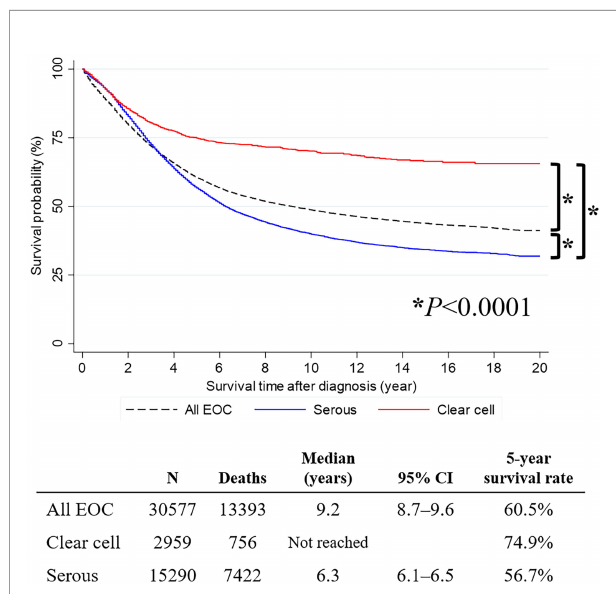
FIGURE 1 | Survival curve of all primary epithelial ovarian cancer, ovarian serous carcinoma, and ovarian clear cell carcinoma